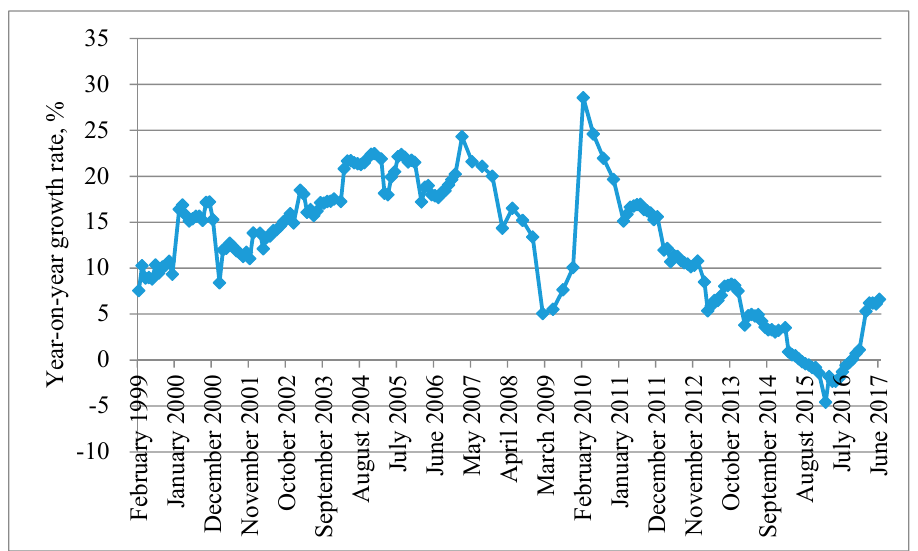
Figure 1. The dynamics in income of electricity and heat generation and supply companies in China. Note: the data come from the National Bureau of Statistics of China.